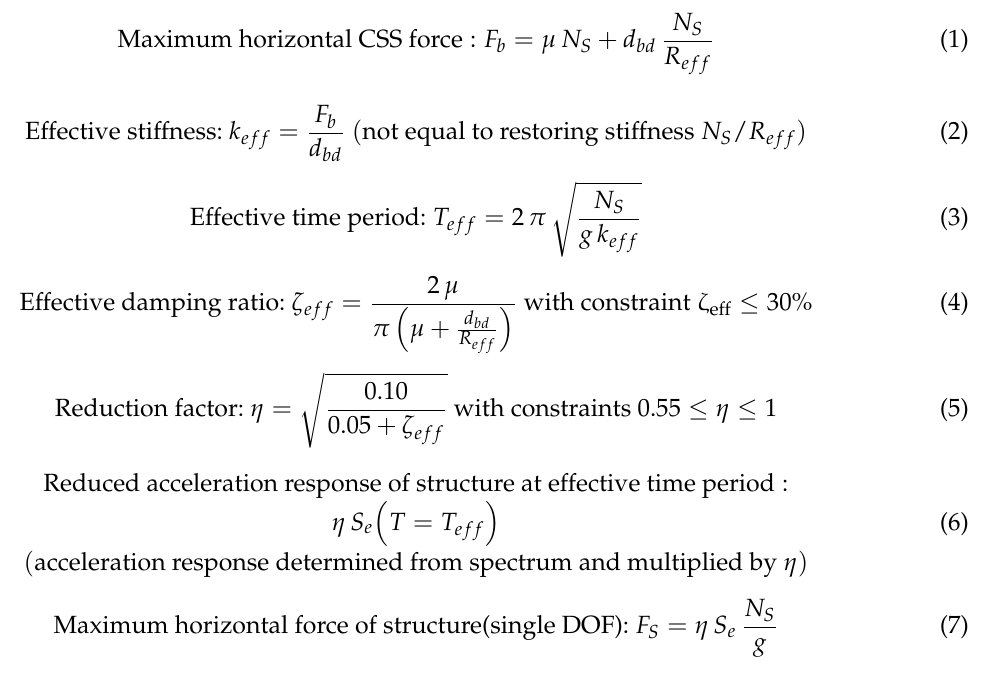
opt d : : displacement capacity of bd bd